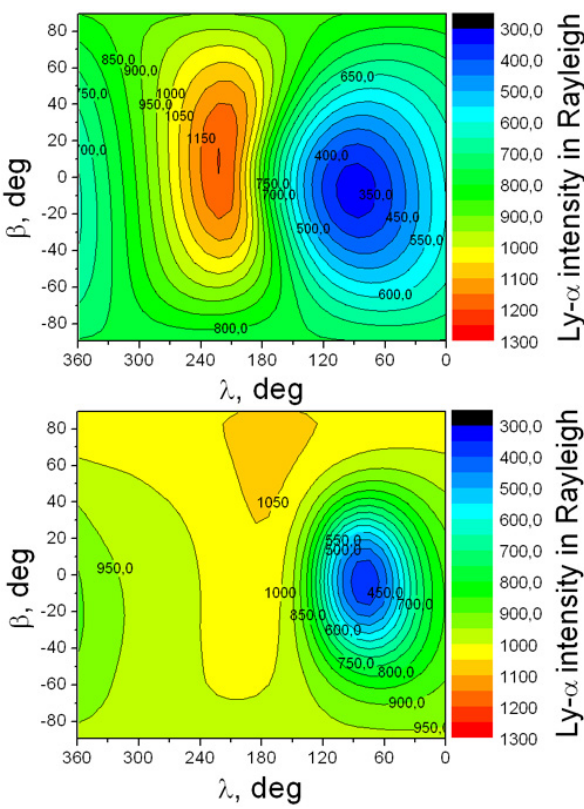
Fig. 7. Used interplanetary Lyman- α glow intensity all-sky-maps as calculated with the hot model. Top: 20 September 2009 (fall equinox). Bottom: 20 June 2010 (summer